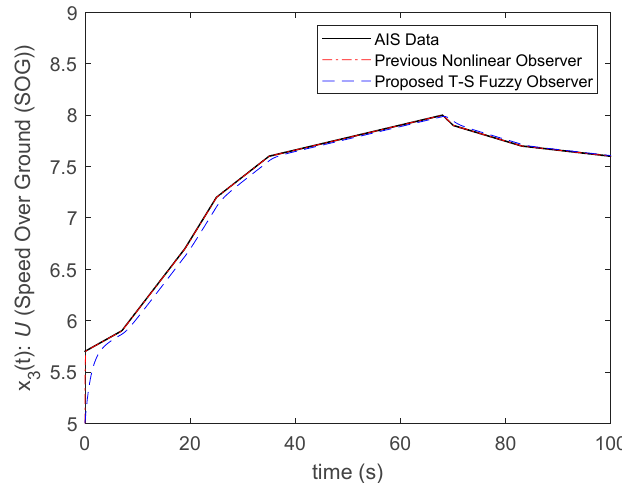
( ) x t with [26]. x t with [26]. 3 3